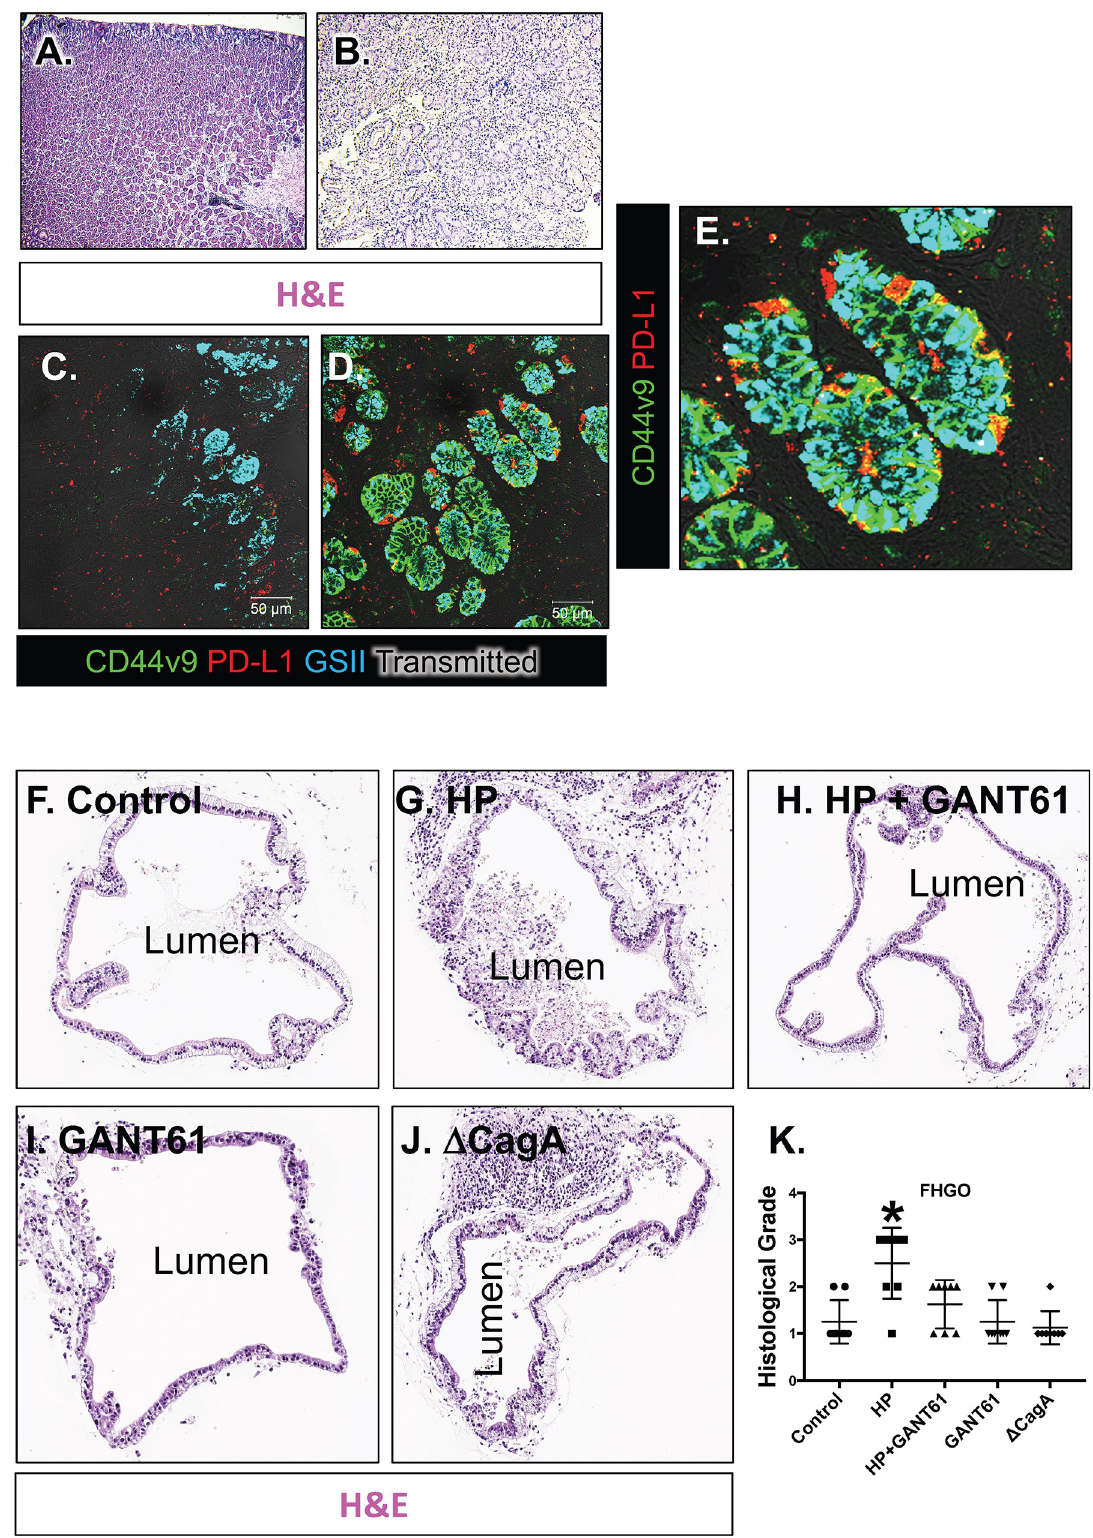
Fig 1. Changes in PD-L1 expression in H . pylori infected human stomach and histological grade of HGOs. H&E staining of biopsies collected from a (A) normal uninfected and (B) H . pylori ( HP) infected patient stomach. Immunofluorescence staining for PD-L1